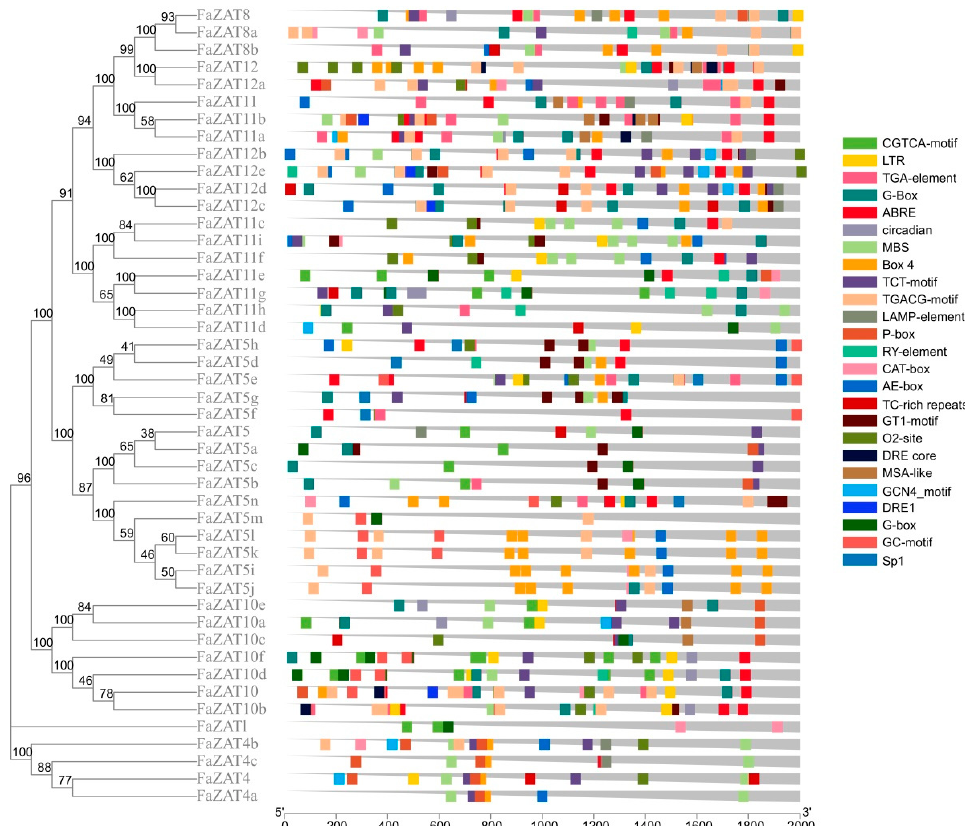
Figure 4. Distribution of cis-acting elements in the promoter of C1-2i subclass members in cultivated strawberry. The phylogenetic tree was developed on MEGA (version 7.0) using the neighborhood-joining phylogenetic method analysis. Both the bootstrap test and the approximate likelihood ratio test were set to 1000 times.